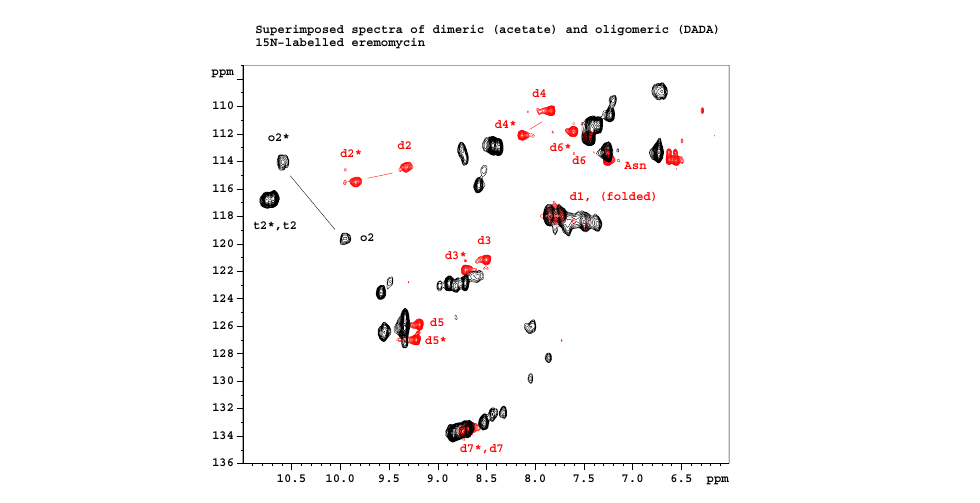
Figure 4. Overlayed 15 N HSQC spectra of N -Ac- D -Ala- D -Ala ligand-filled oligomeric and dimeric eremomycin. Letters d, t and o stand for NH amide groups in dimers, tetramers and octamers, respectively. Numbers denote sequential order. Asterisks (*) label amide NH groups belonging to the same monomeric unit within an asymmetric dimer building block. Not all signals are labeled because of signal overlap.